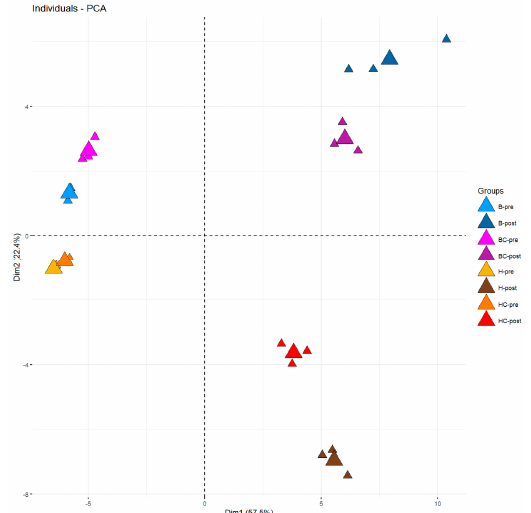
Figure 1. Principal component analysis (PCA) of the volatile compounds found in four honey wines made with blossom honey (B), blossom honey with blackcurrant (BC), honeydew honey (H), and honeydew honey with blackcurrant (HC), analyzed before (pre) and at the end of the fermentation process (post). The first component explained 57.5%, and the second component explained 22.4% of the total variance. Samples replicates are shown by the smaller triangle-shaped dots, while the average is represented by the bigger shaped